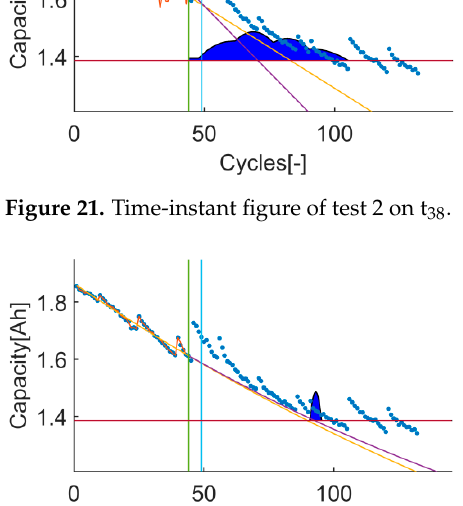
Figure 22. Time-instant figure of test 4 on t 38 .